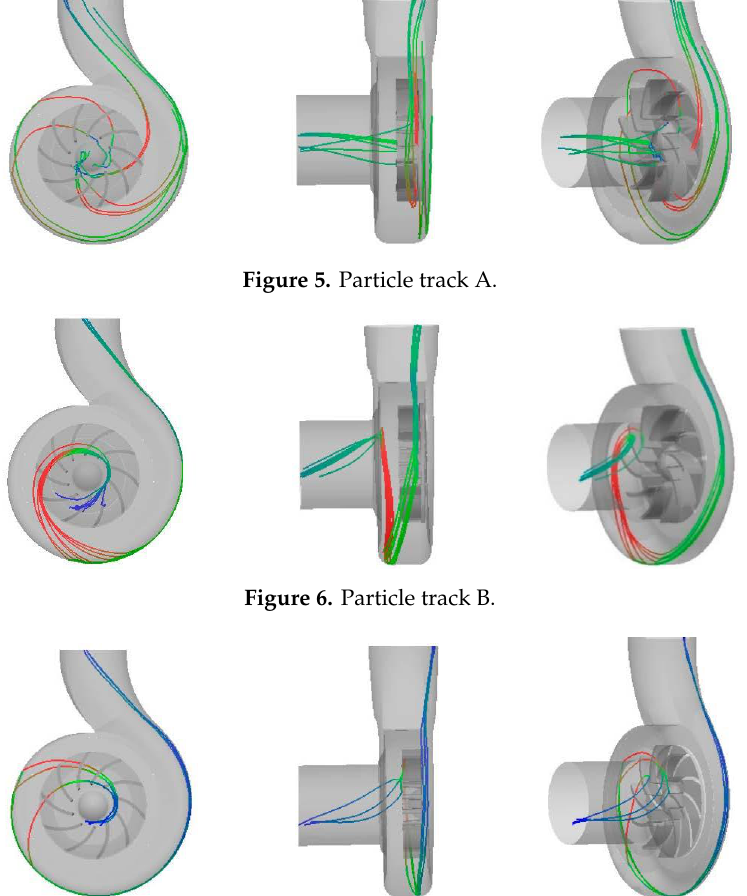
Figure 7. Particle track C.